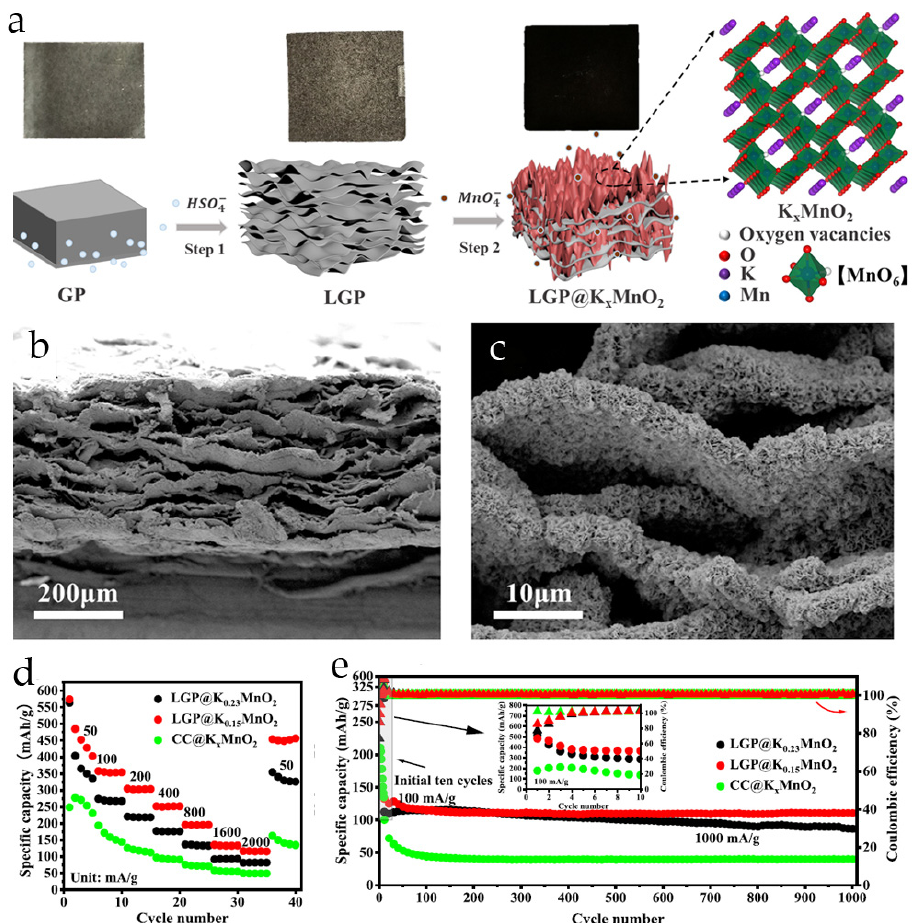
Figure 4. ( a ) Scheme of the preparation process of LGP and synthesis of LGP@K x MnO 2 . ( b , c ) The cross-sectional SEM images of LGP@K 0.15 MnO 2 . ( d ) Rate performance and ( e ) cycling stability and coulombic efficiency at 1000 mA/g of K-doped MnO 2 grown on the layered graphite paper and car-